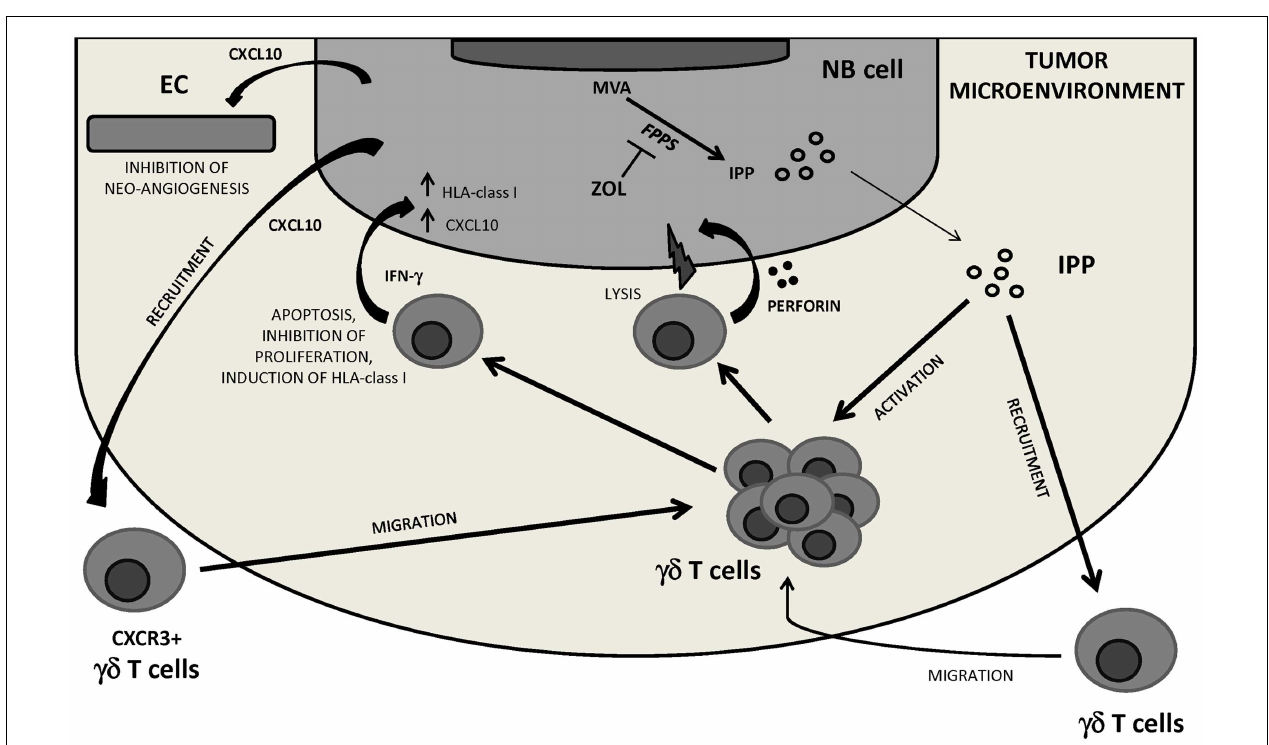
apoptosis.V γ 9V δ 2T cell-secreted IFN- γ can upregulate HLA class I expression on NB cells thus increasing their immunogenicity, and induce CXCL10 expression in tumor cells. CXCL10 may exert anti-angiogenic effects by binding to CXCR3 on endothelial cells and recruit a new wave of CXCR3